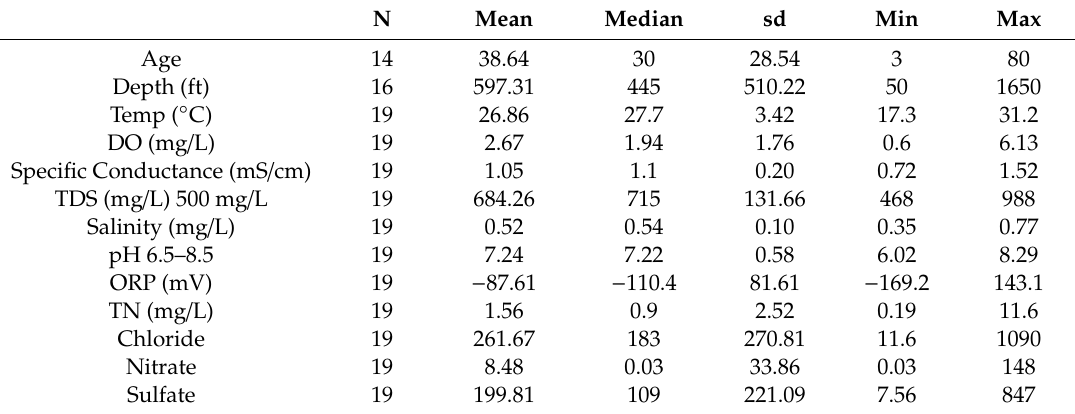
Table 3. Descriptive statistics for the wells sampled and associated parameters